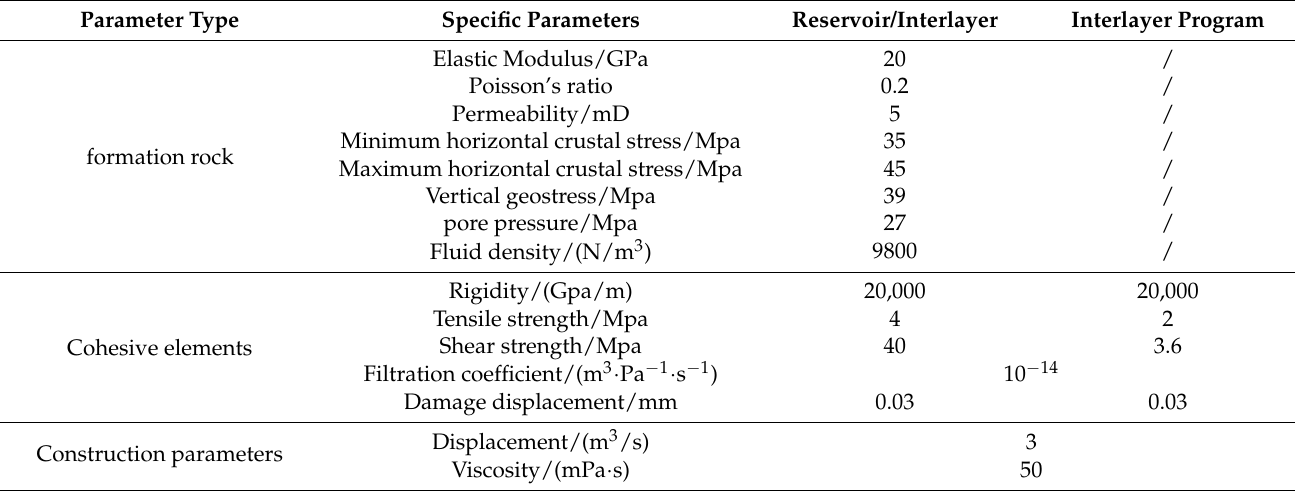
Table 3. The rock mechanics parameters of the